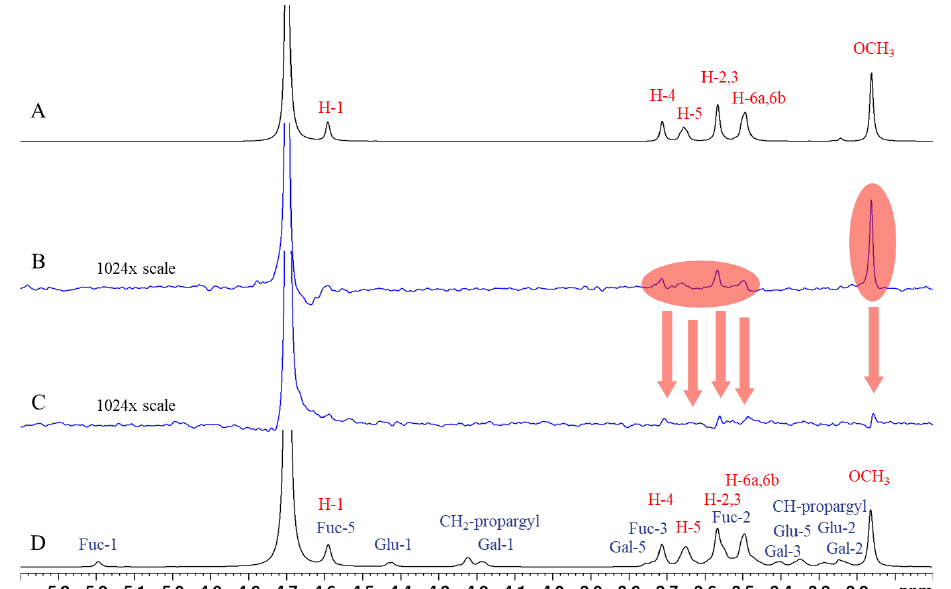
Figure 2. ( A ) 1 H and ( B ) STD NMR spectra of 4 mM Me α -D-Gal in the presence of 40 µ M PA-IL monomer in D 2 O (700 MHz, 20 mM Tris-d 11 , 150 mM NaCl, 5 mM CaCl 2 , pH = 7.5, T = 283 K). ( C ) STD and ( D ) 1 H spectra of the same sample upon addition of 4 mM propargyl glycoside of 3-fucosyl lactose (compound 6 ). The proton signals of the reference ligand are assigned with red color, while those of the competitor are indicated in blue. The well-separated O -methyl signal of Me α -D-Gal serves as excellent indicator for monitoring the competition between the reference ligand and compound 6 . The fractional reduction of the methyl STD intensities (from 100% to 12%) measured in 1:1 molar mixture of the competitor and reference ligand indicates the higher affinity of compound 6 . Int. J. Mol. Sci. 2022 , 23 , x FOR PEER REVIEW